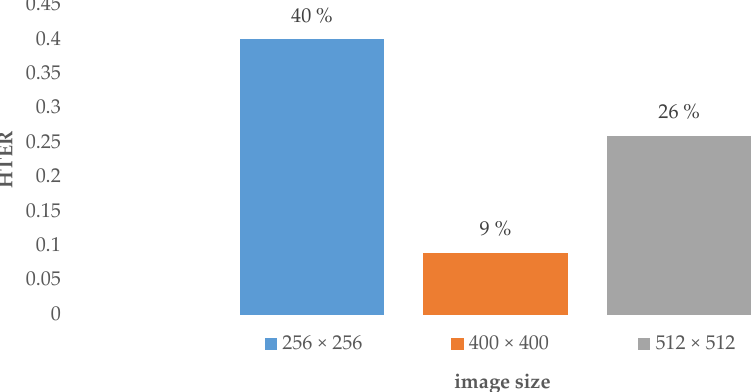
Figure 5. Impact of the input image size in the custom model in terms of HTER (the lower the better). The second hyperparameter analyzed in this section corresponds to the dropout